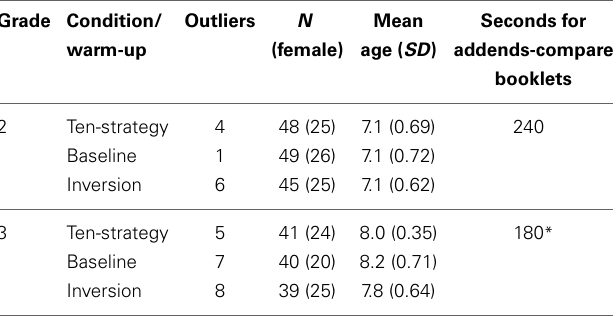
Table 1 | Sample data and time provided per booklet in Experiment